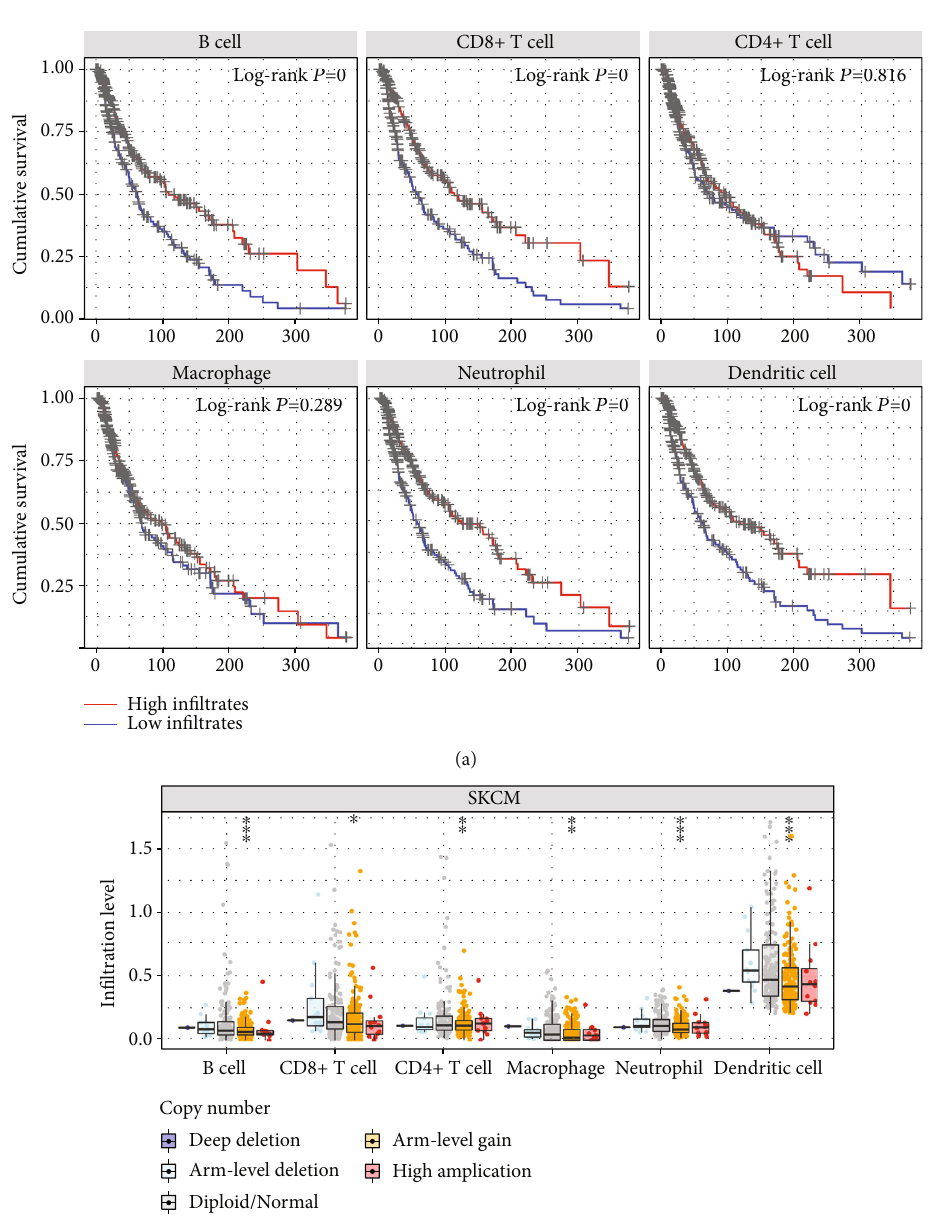
Figure 4: Associations of FLG mutants with immune in fi ltration level and cumulative survival in SKCM. (a) Kaplan-Meier analysis revealed that low in fi ltration levels of B cell, CD8 + T cells, neutrophils, and dendritic cells correlated with poor survival outcomes in SKCM ( P < 0 : 05 ). (b) Mutants of FLG conferred the low in fi ltration levels of immune